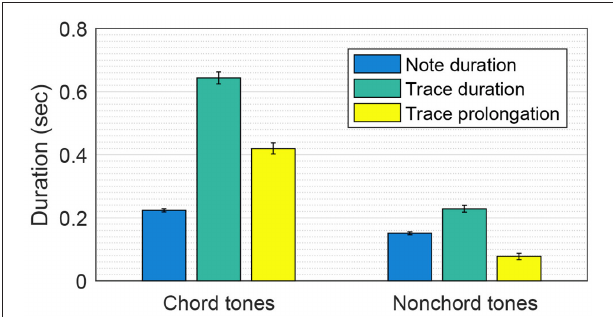
FIGURE 3 | Comparison of the trace prolongations for chord tones and nonchord tones in the Mozart melodies. Mean note duration, mean trace duration and mean trace prolongation (i.e., trace duration shown. The error bars indicate standard errors.